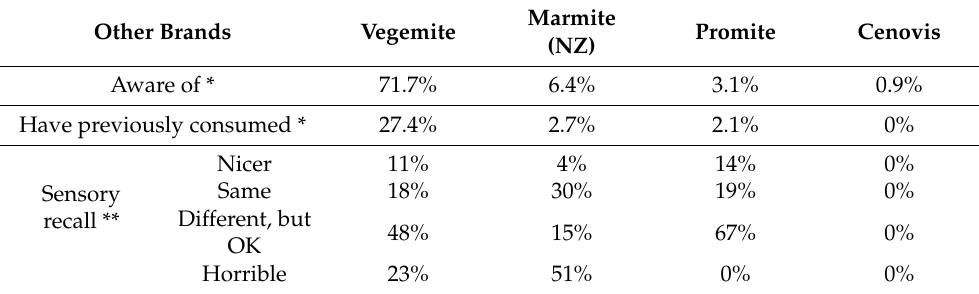
Table 4. Awareness and consumption of other (national) yeast spreads brands in the United Kingdom ( n = 702). Marmite Promite Cenovis Other Brands Vegemite (NZ) Aware of * 71.7% 6.4% 3.1% 0.9% Have previously consumed * 27.4% 2.7% 2.1% 0% Nicer 11% 4%